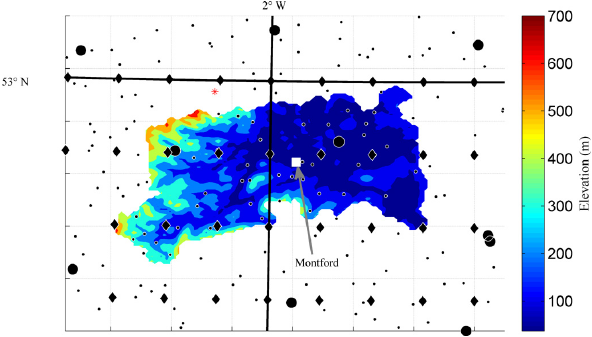
Fig. 1. Station data in the Upper Severn catchment showing daily stations (small black dots) and hourly stations (large black dots) used to interpolate the precipitation grid. The black diamonds are the location of the grid points from the ECMWF forecast and the white box denotes the location of the Montford station.